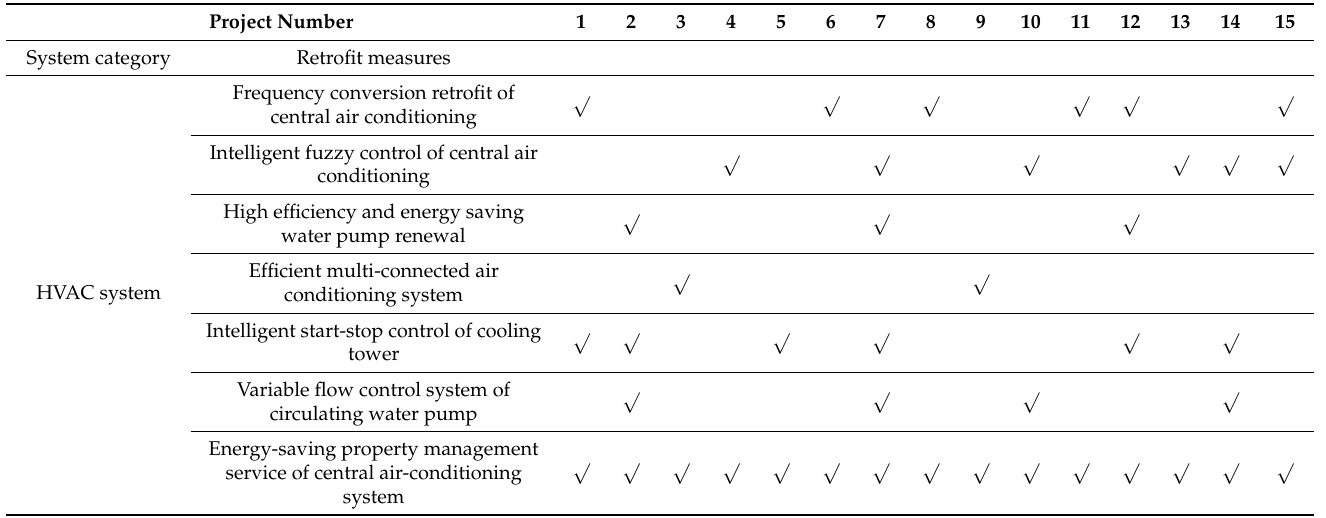
Table 2. Application information of energy-saving retrofit technology of existing